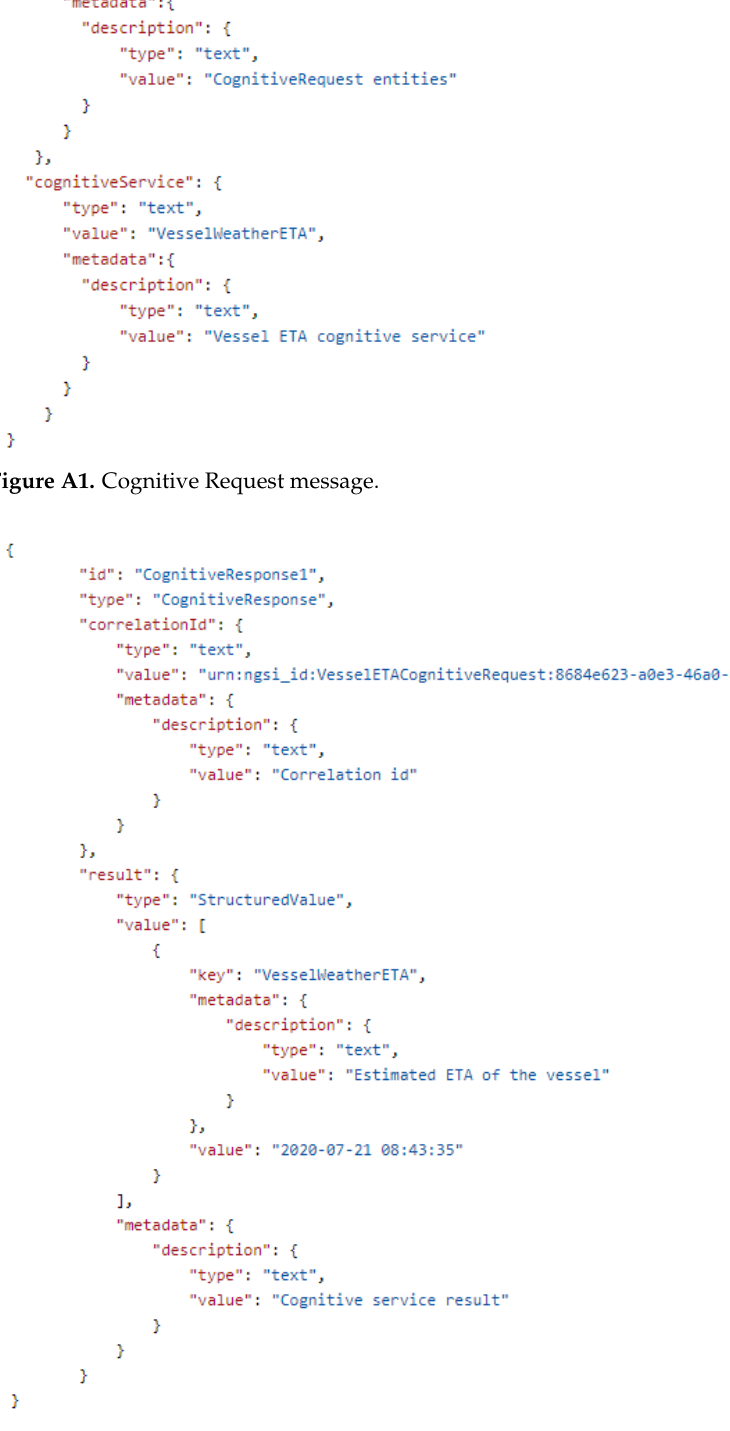
Figure A2. Cognitive Response